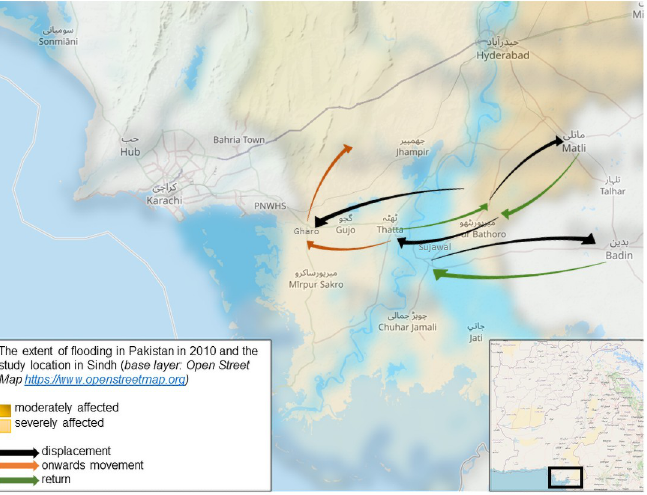
Fig 1. Location of fieldwork in Sindh in Pakistan and major displacement routes during the 2010 superfloods.